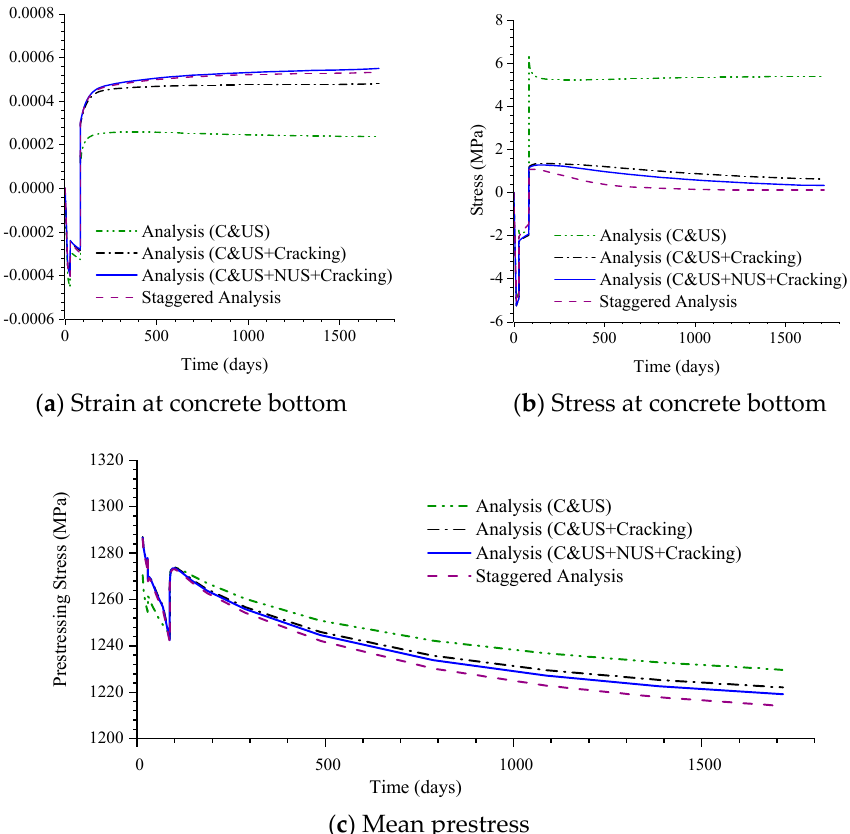
Figure 9. Variation of strain and stress of concrete bottom and mean prestress at the mid-span section with time in the short-span PSC beam.